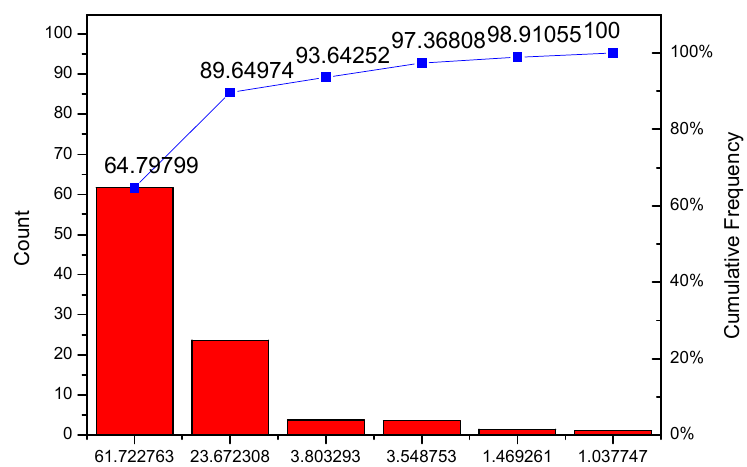
Figure A1. Scree plot of first six PCs, carrying over 99.9% of variance. Table A2. Descriptor-wise loadings of the first six PCs. Bold numbers indicate significant loadings.